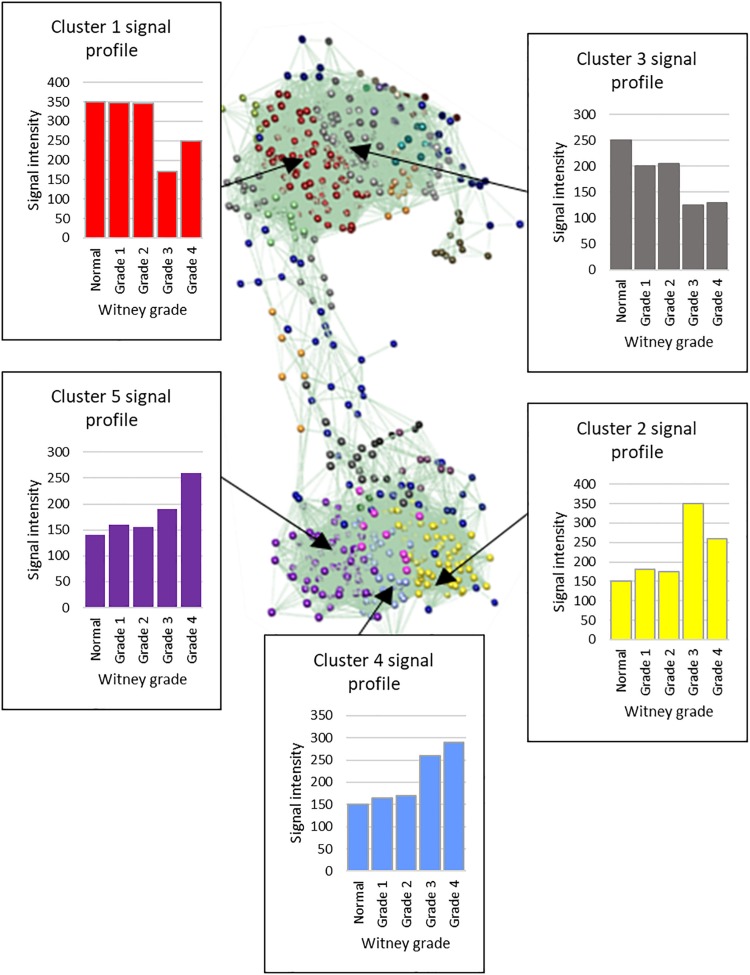
Graphia Pro 1.4 cluster optimization with MCL clustering (inflation value 2.2) of 1002 differentially expressed genes. Five largest clusters from the optimized MCL clustering data show changes with increasing Whitney grade of disease. Cluster 1, 233 genes; Cluster 2, 206 genes; Cluster 3, 147 genes; Cluster 4, 96 genes; Cluster 5, 80. Average expression values across the cluster are shown.